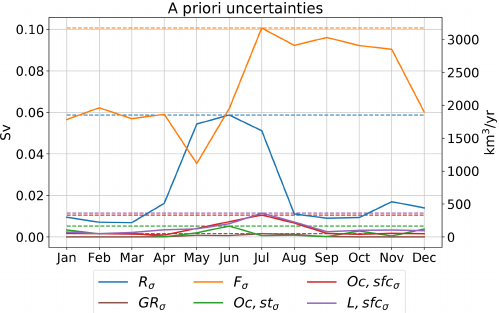
Figure 11. Mean annual cycles (1993–2018) of spread for runoff ( R ), Greenland runoff (GR), lateral ocean fluxes ( F ), oceanic storage (Oc, st), and atmospheric input over ocean (Oc, sfc) and land ( L , sfc). Spread is calculated as the standard deviation between various estimates (see Table 9) of the individual terms and as an RMSE estimate for GRACE.